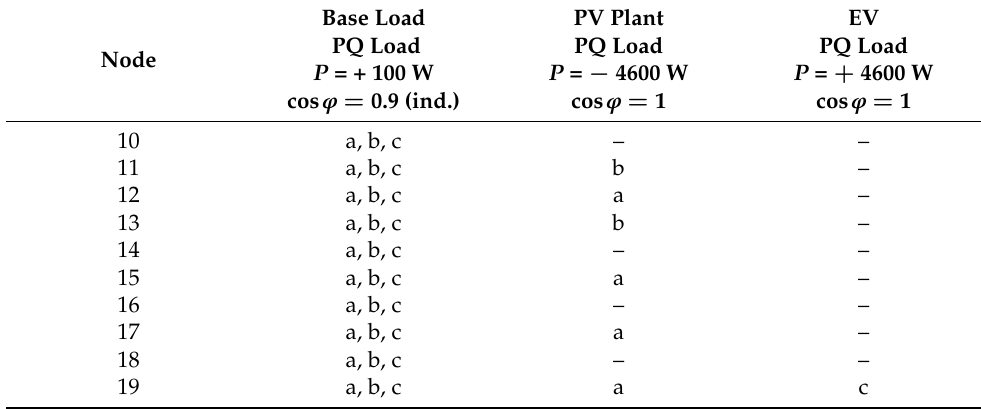
Table 9. Allocation of loads to costumer nodes and phases (Base scenario